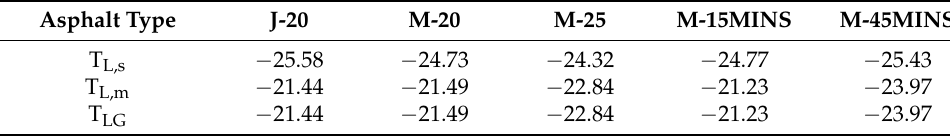
Table 3. Low-temperature grade temperature (T LG ) of asphalt